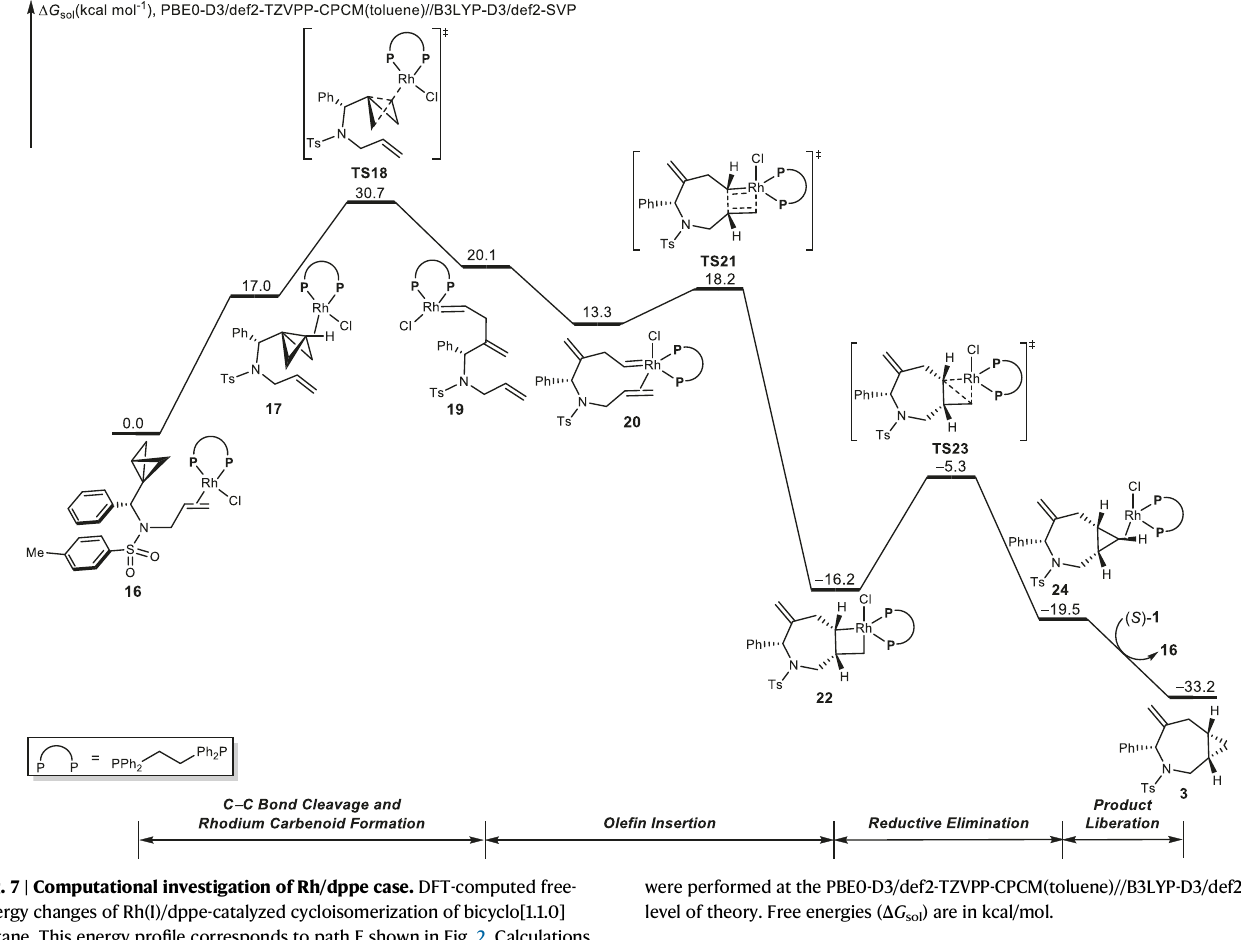
were performed at the PBE0-D3/def2-TZVPP-CPCM(toluene)//B3LYP-D3/def2-SVP level of theory. Free energies ( Δ G sol ) are in